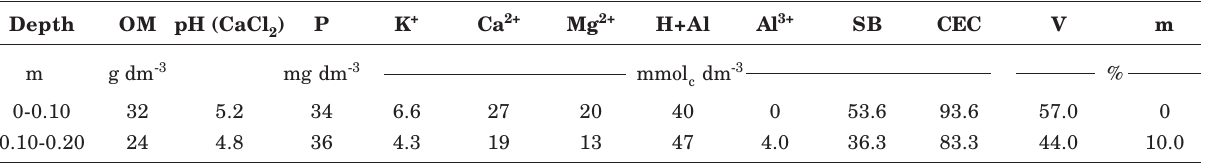
(1) OM: organic matter, SB: sum of bases, CEC: cation exchange capacity, V%: base saturation index, m%: aluminum saturation